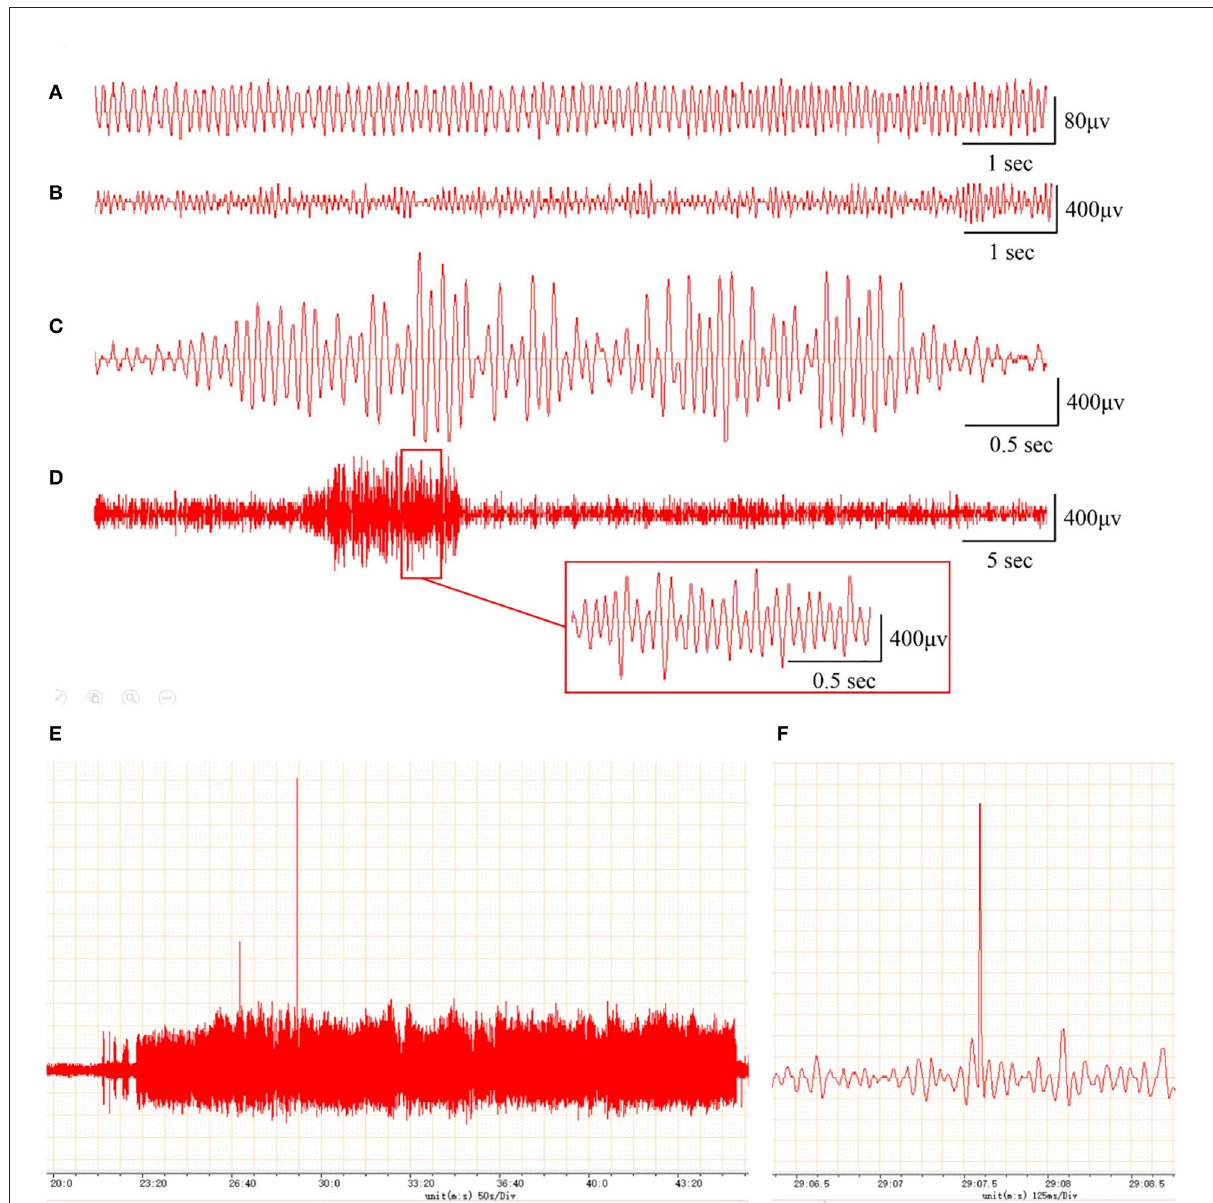
FIGURE1 Rats with FeCl 2 injection-induced post-traumatic epilepsy (PTE) showed epileptiform discharges on electroencephalogram (EEG). A total of 12 rats were randomly divided into sham and PTE groups ( n = 6/group). Rats in PTE group were injected with 10- µ l FeCl 2 (0.4 mol/L, 1 µ l/min) at right frontal cortex. Sham group underwent same procedures except for injection. A 1-h EEG, including first 15min and blocks of 10min at 5-min intervals, was recorded at 1h before injection and at 1h and 1, 7, and 30 days after injection. Representative EEGs are shown. (A) Normal EEG at 60min before injection. Multiple spikes (B) , two- and three-phase sharp waves (C) , 10-s continuous abnormal discharges (D) , 20-min explosive abnormal discharges with occasional high-amplitude spikes (E) , and a sudden high-amplitude spike (F) were observed on day 30 after